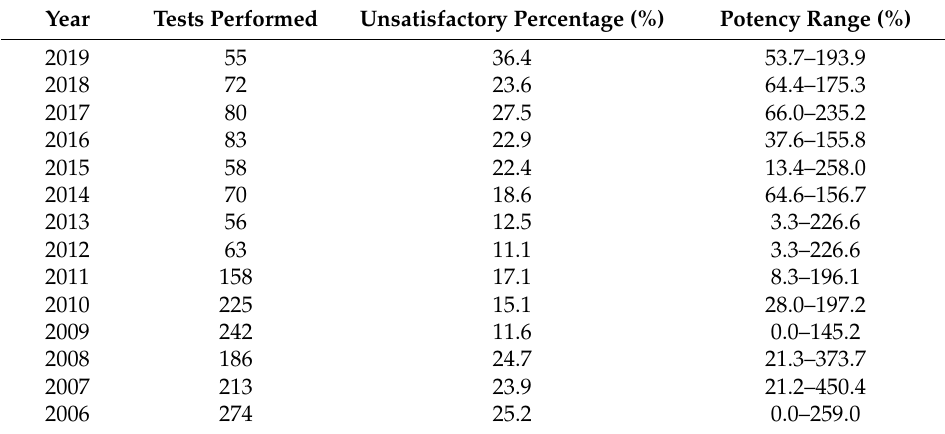
Table 1. Results obtained of the potency ranges of extemporaneously manufactured drug products prepared between the years 2006–2019. The tests were conducted by The Missouri Board of